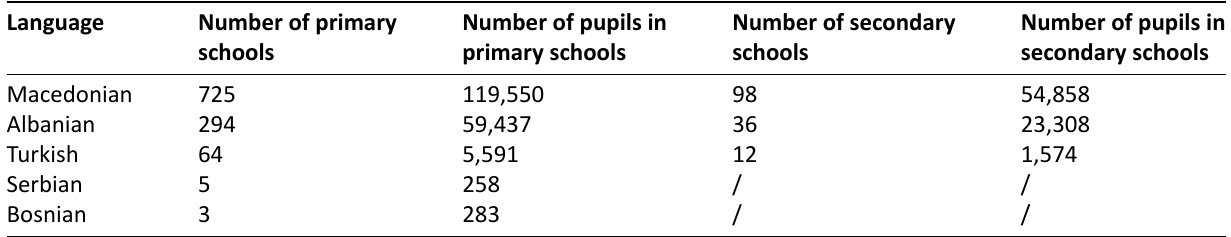
Table 2. Primary and secondary schools according to the language of instructions in 2015–2016.